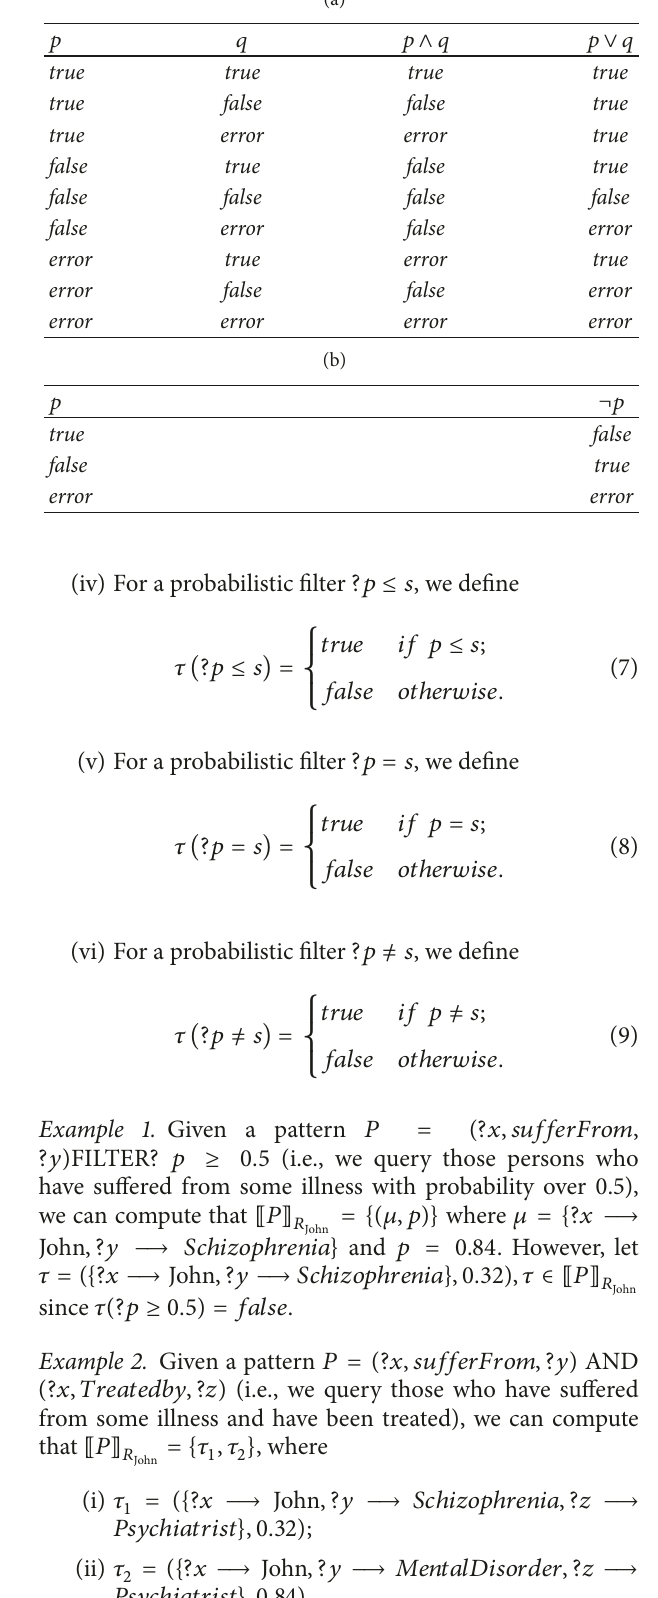
Table 1: Truth tables for the three-valued